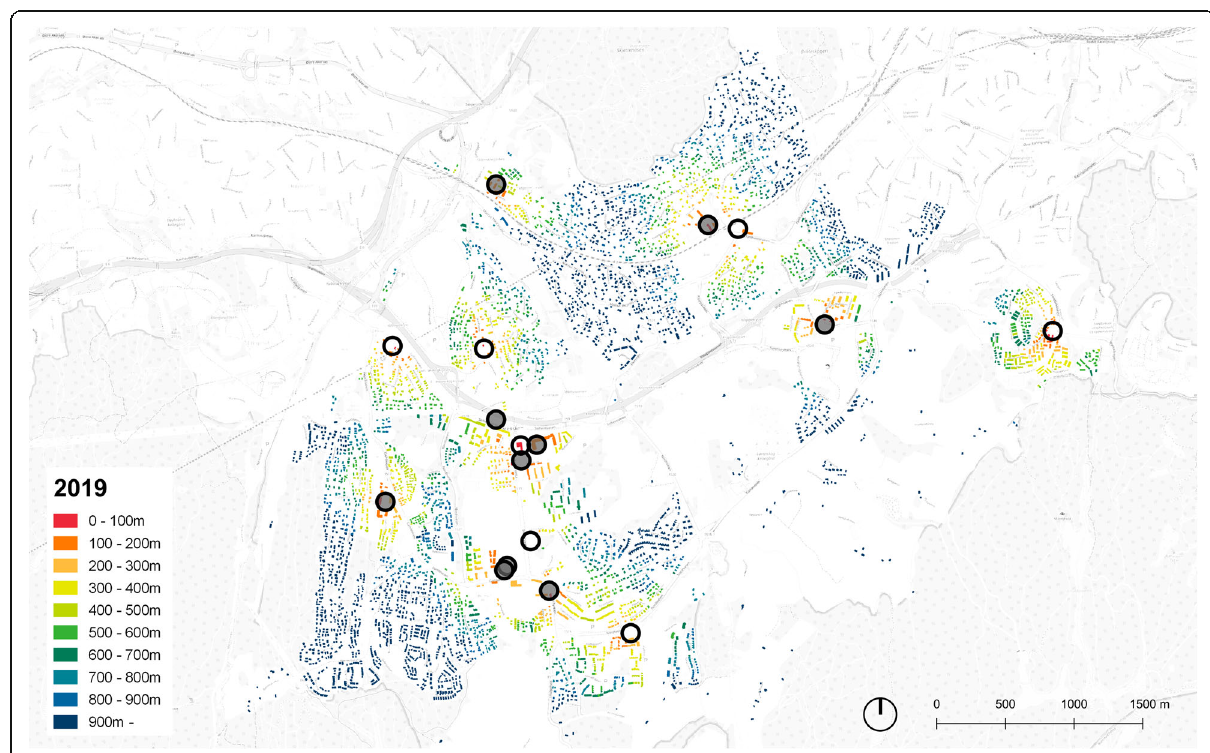
Fig. 6 Distance to grocery stores, Lørenskog, 2019. Stores marked with circles, filled circles representing stores opened since 1980